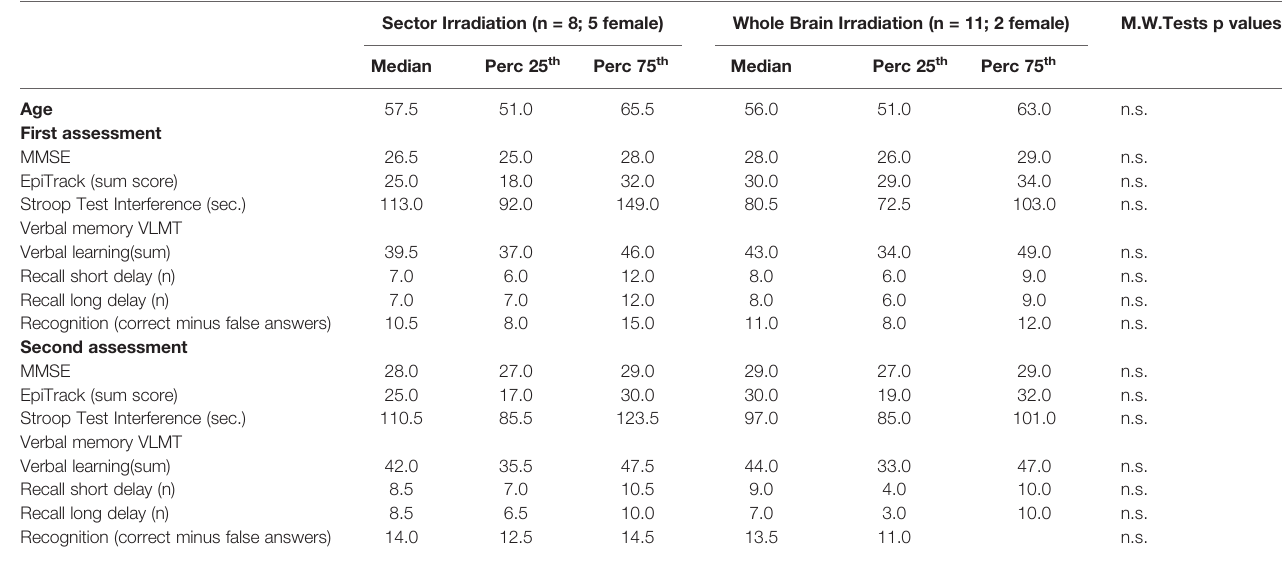
TABLE 3 | Demographic and neuropsychological variables; between-group